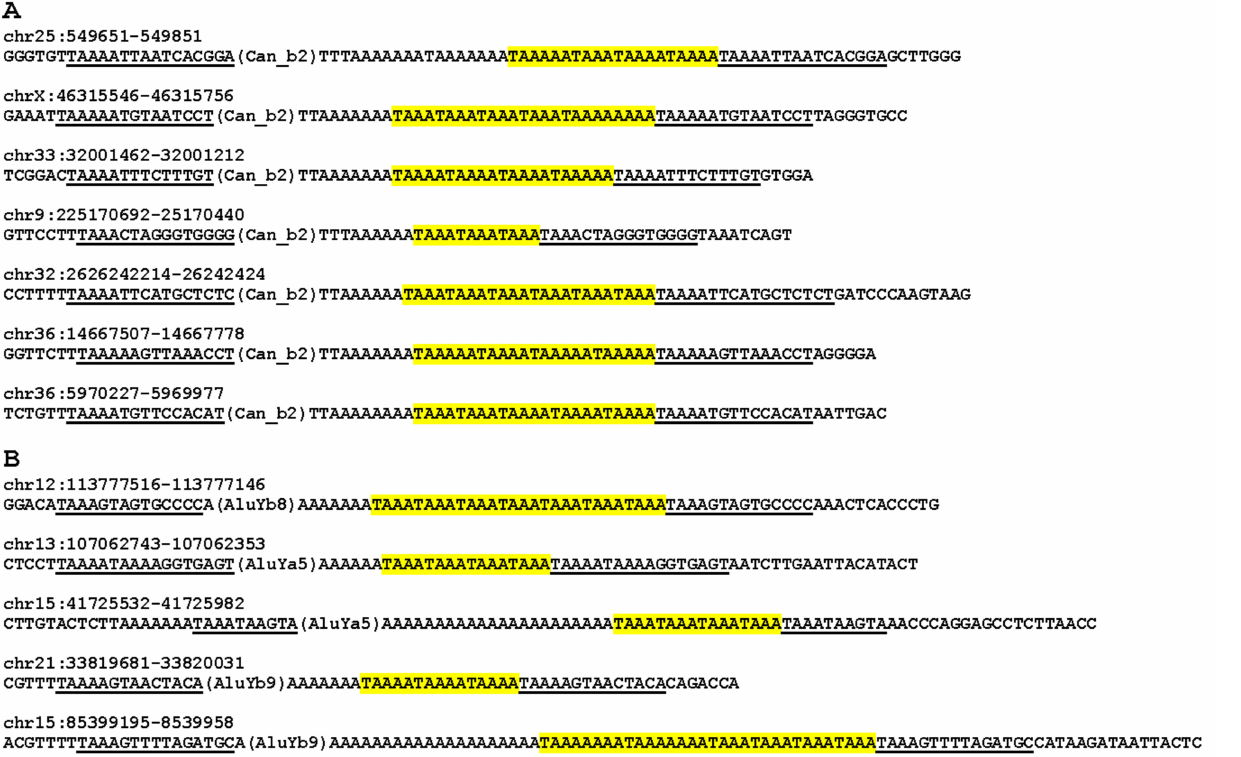
Figure 9. Examples of A-tails of SINEs with TA 3–5 repeats (shown in yellow) and flanking sequences containing TSDs (underlined). ( A ) Can_b2; ( B ) Alu. Notice that TSDs start with TA 3–5 . The SINE coordinates in the German Shepherd and human genomes are given above